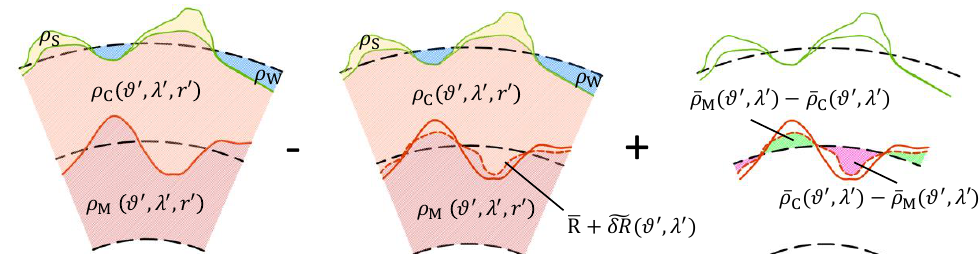
Figure 2. Scheme of the updated data reduction procedure according to Equation (21), considering also vertical density variations. The approximated shape of the Moho undulation (cid:102) δ R ( ϑ (cid:48) , λ (cid:48) ) , required for the iterative procedure, is depicted with a red dashed